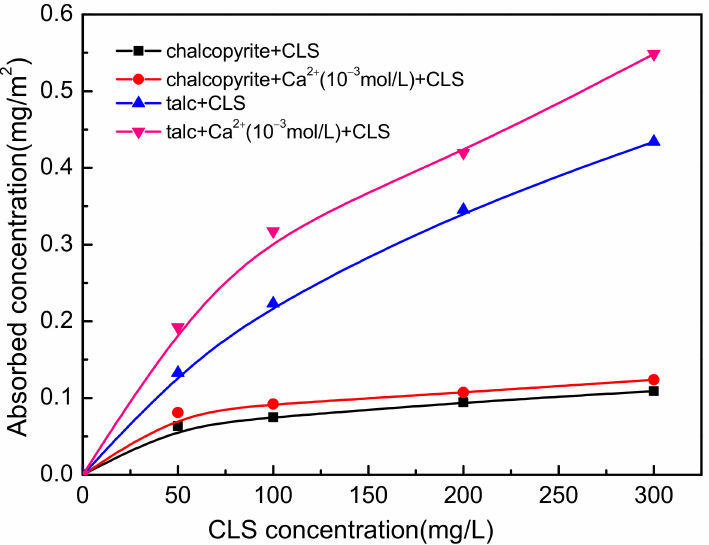
Figure 7. Adsorption behavior of CLS on chalcopyrite and talc with/without the presence of Ca 2+ ions at pH